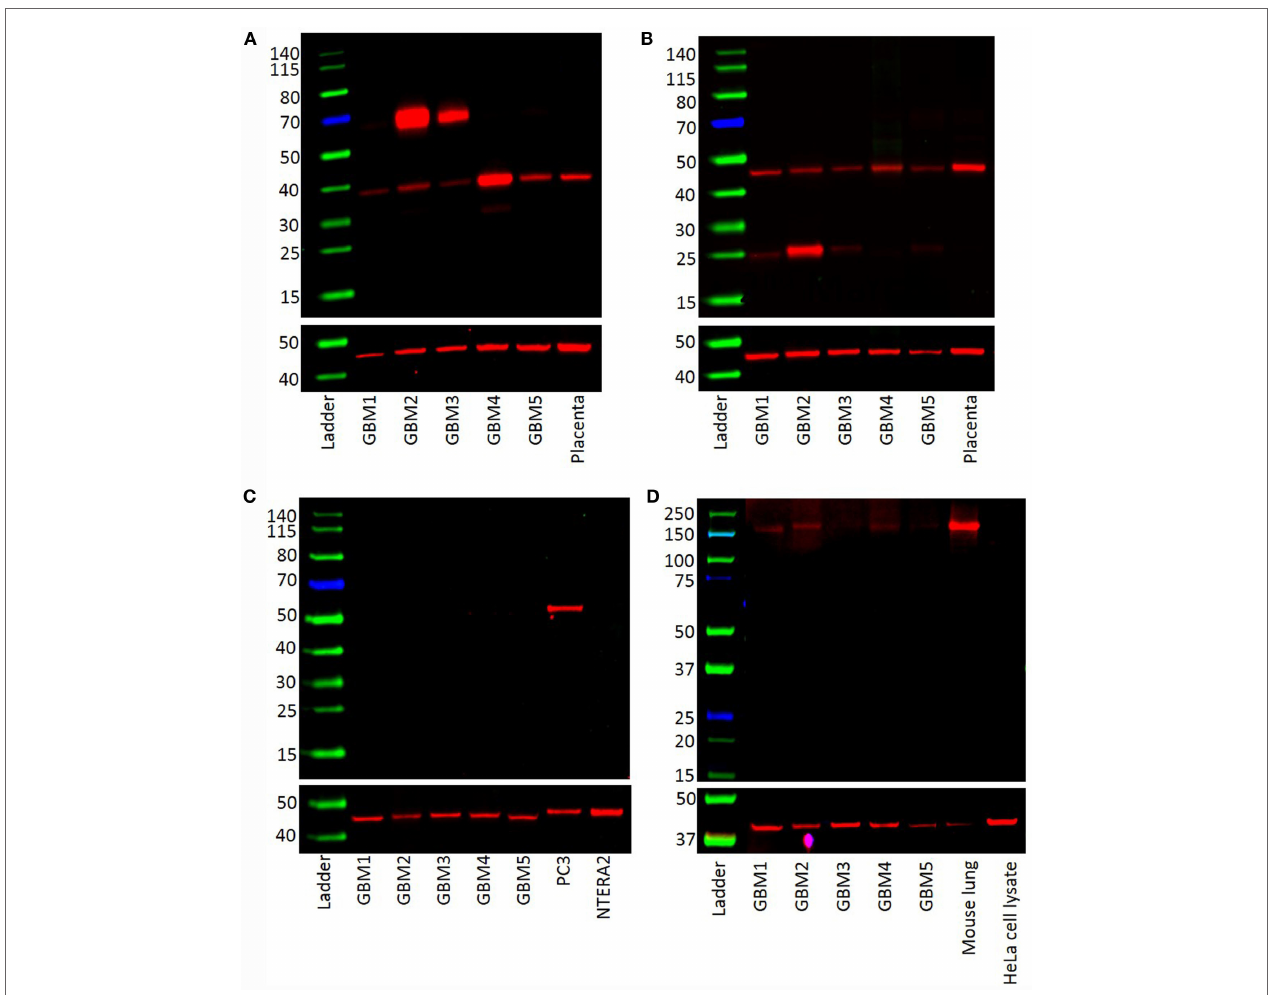
FigUre 3 | Western blots demonstrating the expression of Prr (~38 kDa) (a) and aTiir1 (~45 kDa) (B) in all five gBM samples . ATIIR2 was not detected in any of the samples (c) . ACE was detected in four out of the five GBM samples examined (D)